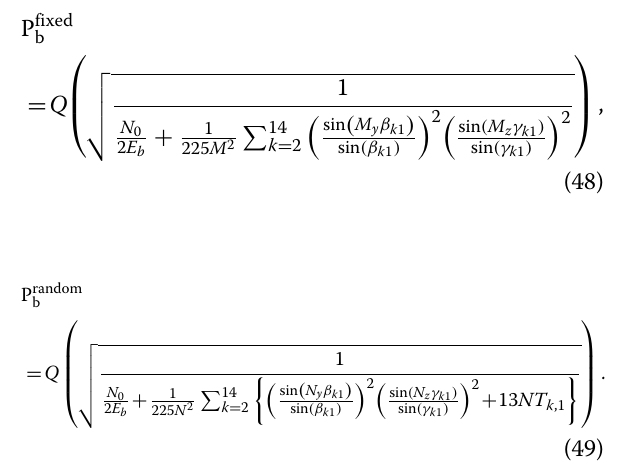
that the theoretical BER curves are well matched with the simulated curves. In contrast with random selection, the number of random variables summed together ( K = 14) is not large enough in the fixed selection which gives a slight